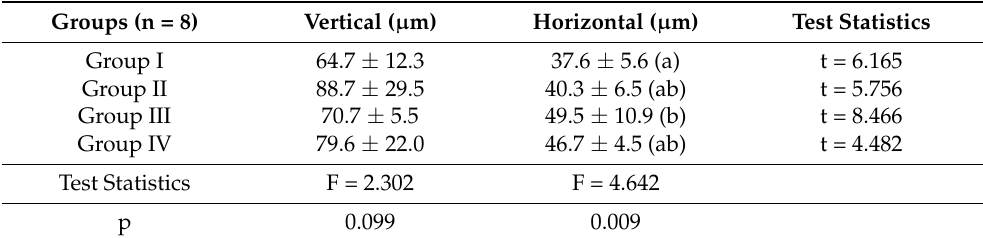
Table 5. Comparison of the mean values of the vertical and horizontal dimensions of the m. coccygeus muscle by